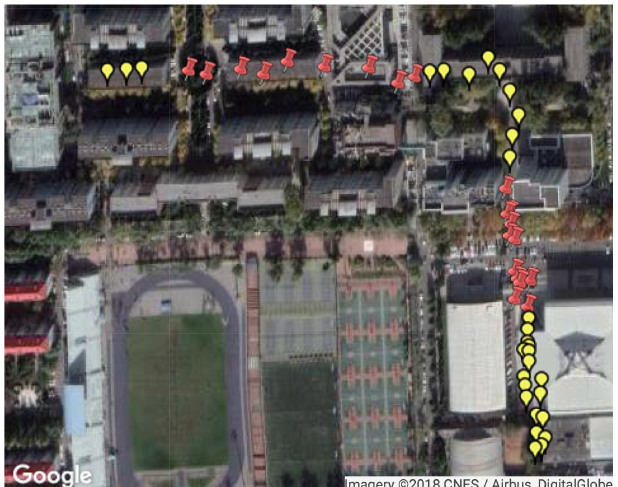
Figure 6. Illustration of points with and without manual satellite loss at Site 1. The red pushpins are points with satellite loss.